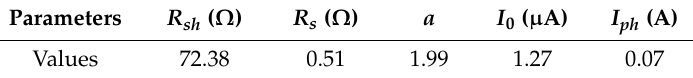
Figure 6. Comparison between experimental data (green dots) and the algorithm calculated I–V curve (blue line) for the FSTT solar cell.